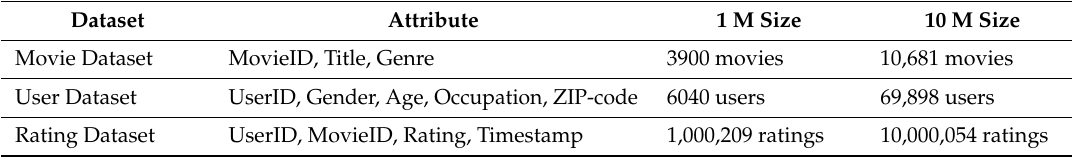
Table 3. GroupLens movie database.